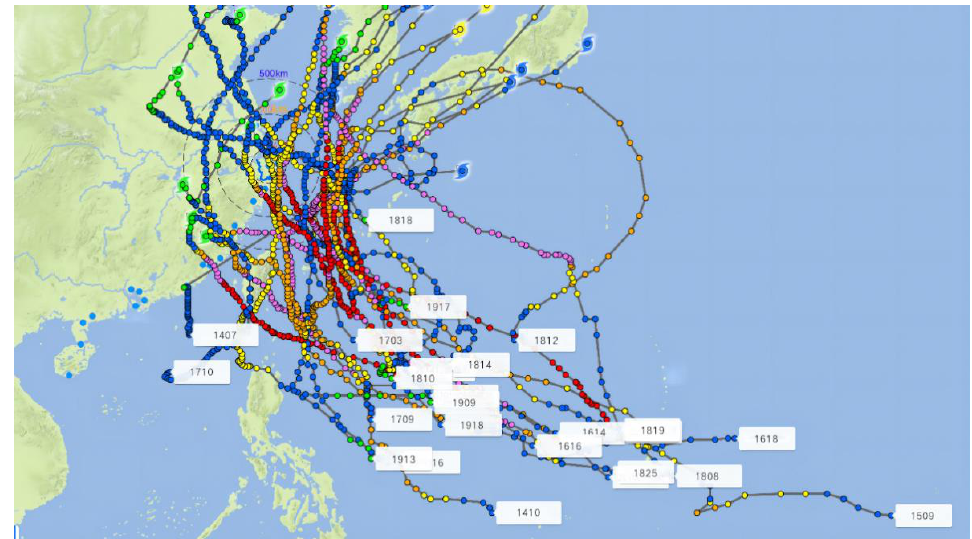
Figure 1. Twenty-five typhoon paths affecting Ningbo area during 2014 – 2019.